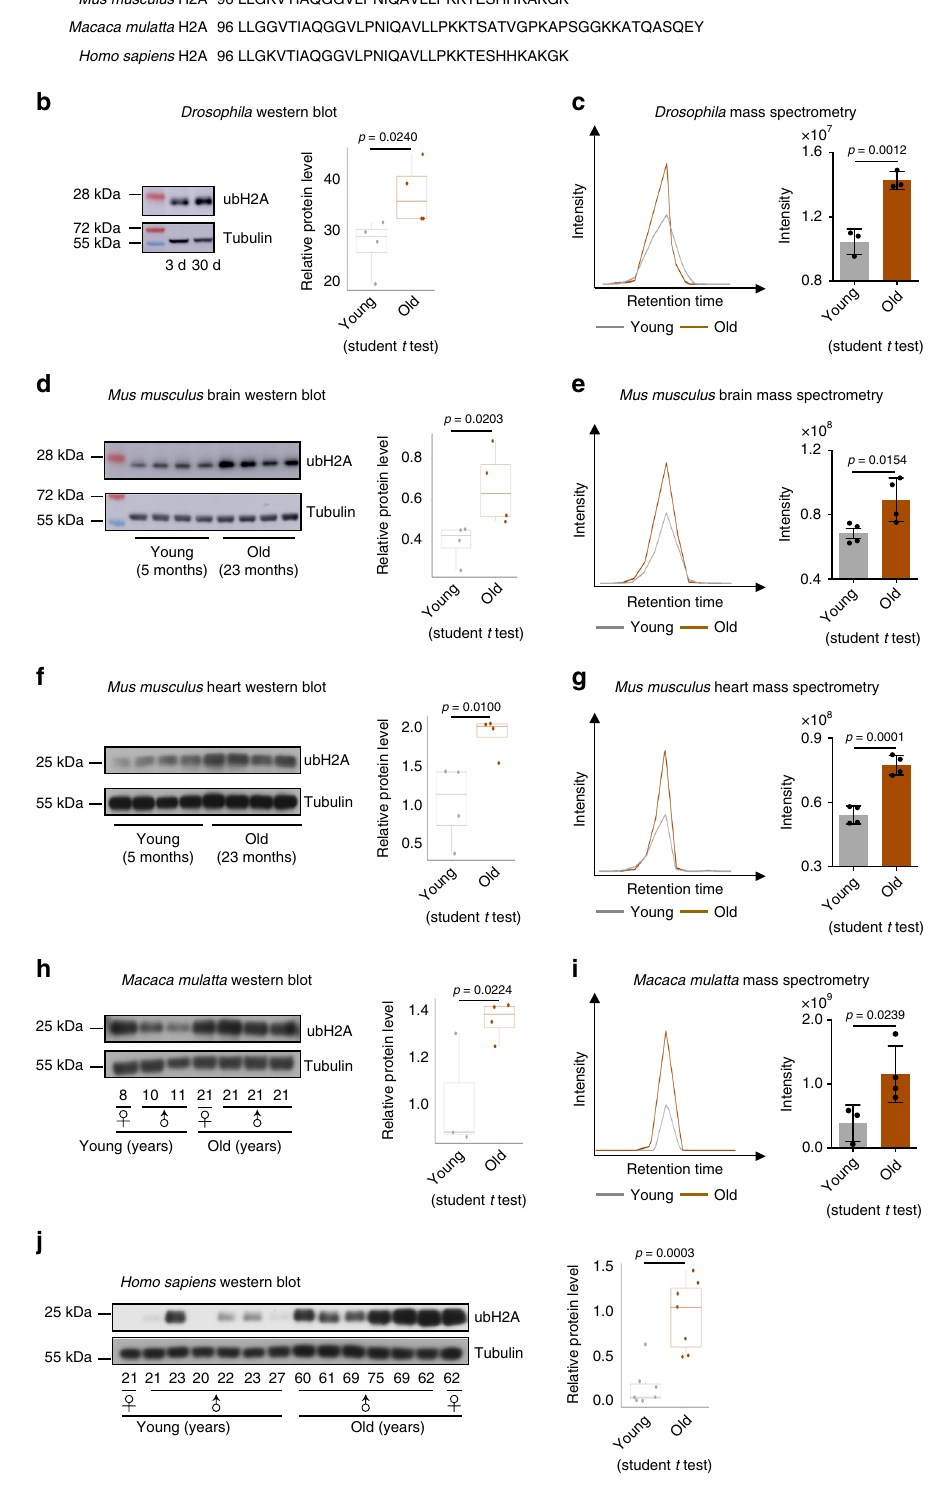
further analyzed adult survival using Sce c244 , Su(z)2 c433 trans- heterozygous double mutants. Remarkably, double mutant male fl ies exhibited more striking effects on life-extension than single mutants (Fig. 4a). Consistently, female fl ies de fi cient in Sce and Su (z)2 also manifested extended longevity and reduced levels